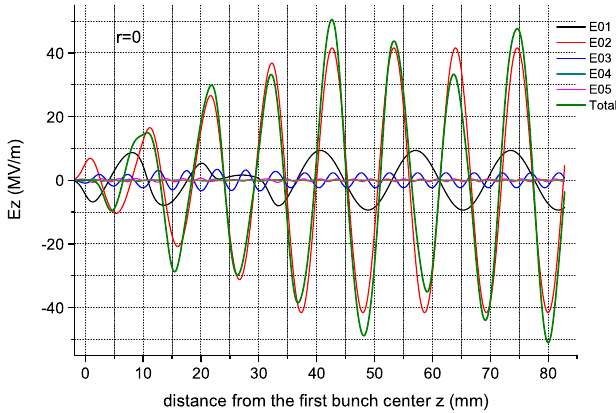
FIG. 21. (Color) Results of PIC simulations of axial (blue line) mm.FIG. 20. (Color) Results of analytical computations of axial and transverse (red line) forces acting upon an electron versus z , profiles of the longitudinal composite field (green line) and at r ¼ 0 : 98 mm from the central axis in a witness bunch chan- modes (labeled as E ) excited longitudinal fields of the E nel. The coaxial structure is excited by the train of four bunches. 0 m 0 m by the train of four bunches along the center of the accelerating Drive bunches move from left to right. The head of the first channel. Drive bunches move from right to left and the center of bunch is located at z (cid:1) 174 mm . Bunch spacing is 10.7 mm. The the first bunch is located at z ¼ 0 . Bunch spacing is about cathode length is 3 mm, the length of dielectric tubes is 173 mm, 10.7 mm. and the length of the extra vacuum gap is 10